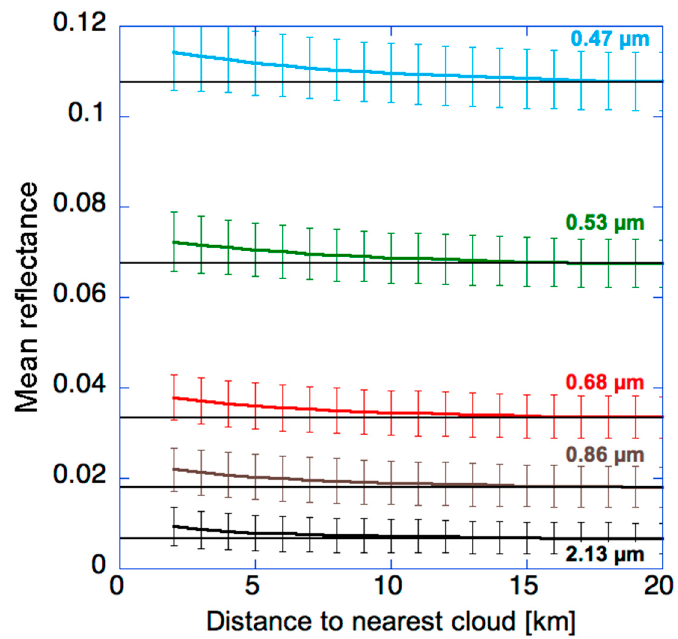
Figure 2. Mean MODIS clear-sky reflectances at various wavelengths over a region of the Northeast Atlantic Ocean (45–50° N, 5–25° W). The horizontal lines indicate mean clear-sky reflectances 20 km away from clouds. The error bars indicate the standard deviation of data values. The plot combines near-nadir observations obtained during the 14–29 September period in 10 years (2002–2011). (The study area is essentially a subset of a wider region where aerosol–cloud relationships were explored in [37]. The smaller spatial extent and the brief periods in each year help the analysis of reflectance values by limiting complications from changes in solar elevation.) The figure is based on Figure 1a of [38].